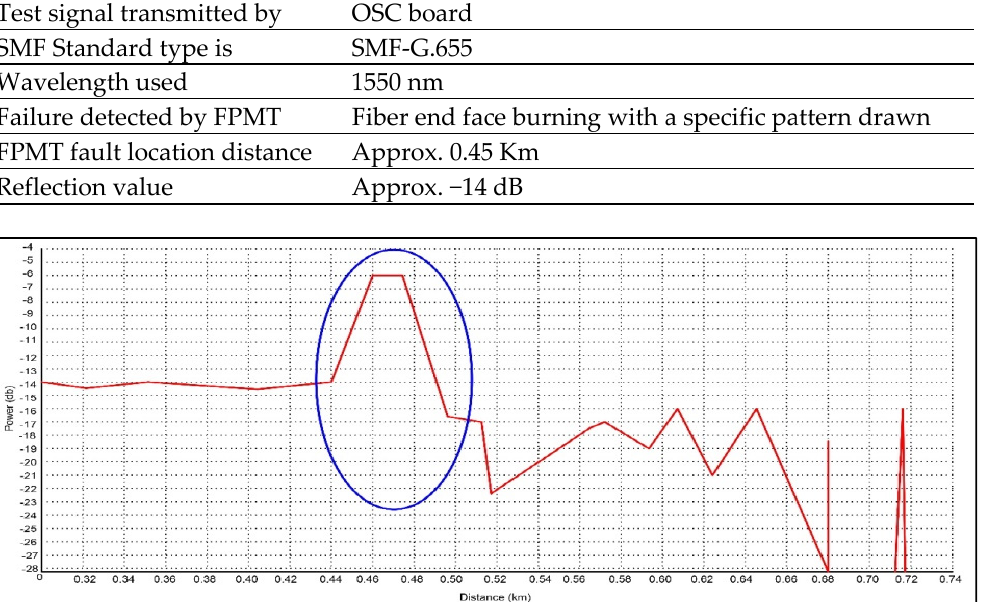
Figure 11. Event is Fiber break (standard SMF G.655 at 1550 nm was used and FPMT test signal was transmitted by the OSC board).